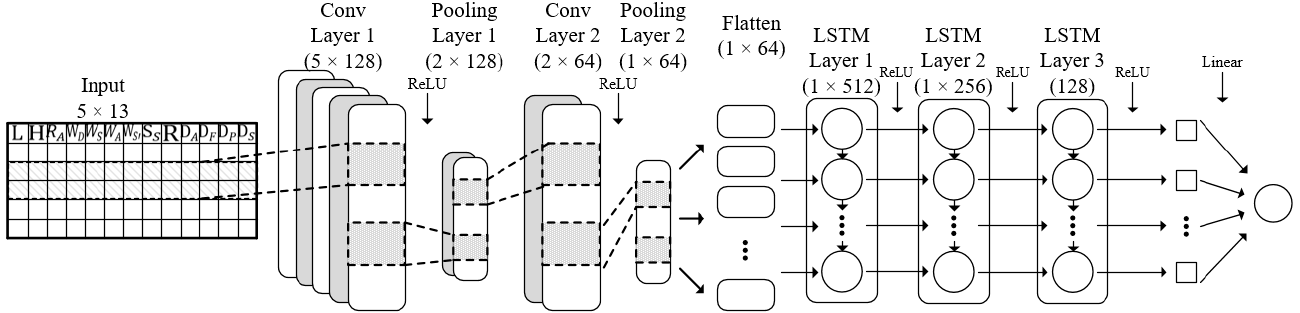
Figure 2. Construction of CNN–LSTM (direct).